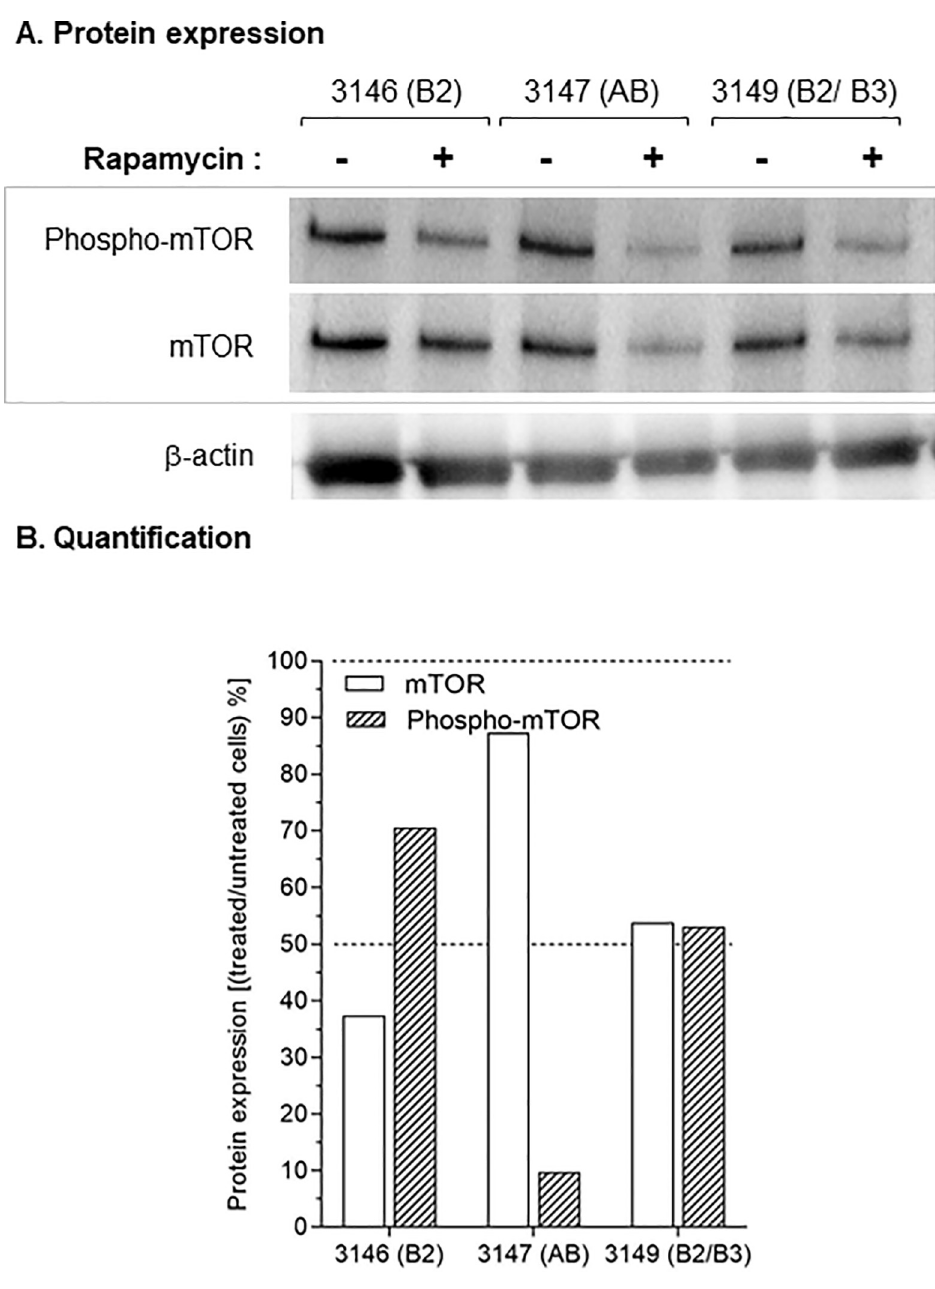
Fig 5. Inhibition of mTOR and phospho-mTOR expression upon rapamycin treatment of thymoma- derived cells. A. Expression of mTOR and phospho-mTOR proteins in thymoma-derived cells after 48 hours treatment with 100 nM rapamycin (+) or no rapamycin (-). B. Protein expression of mTOR (with bars) and Phospho-mTOR (hatched bars) has been measured and expressed as the ratio of protein expression in [treated/ untreated] cells.